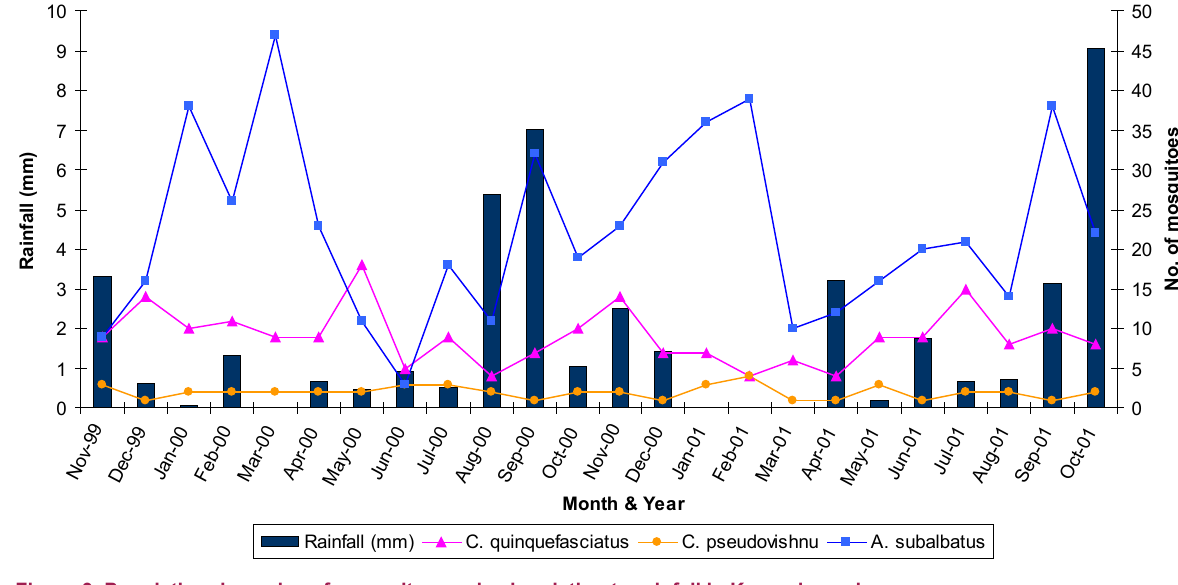
Figure 9. Population dynamics of mosquito species in relation to rainfall in Kavundampalayam